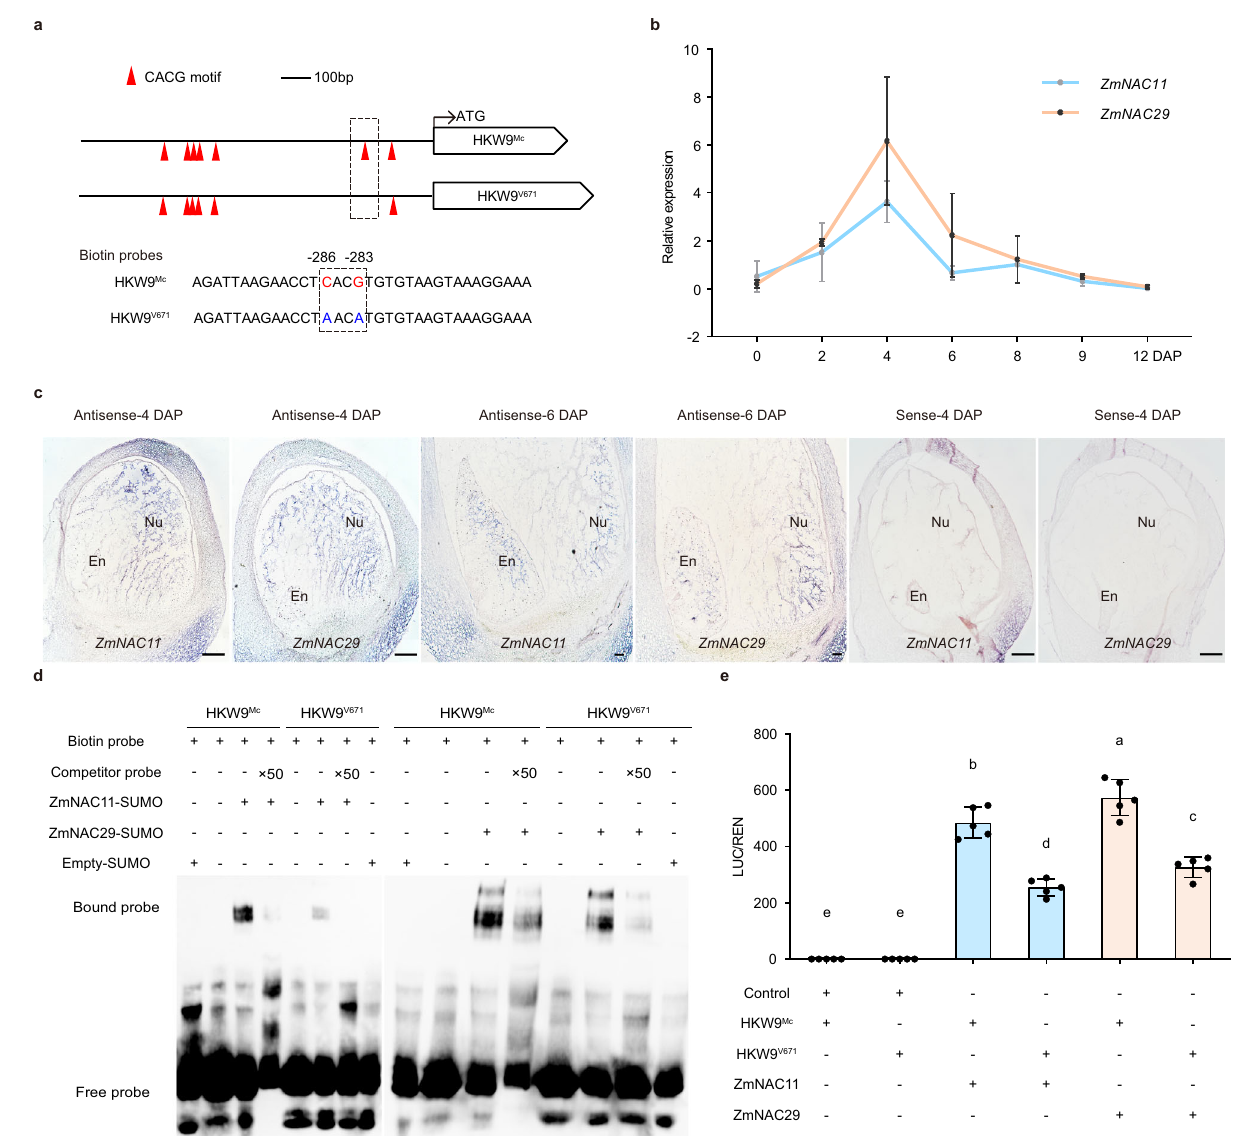
Fig. 5 | Nucellus-expressed ZmNAC11 and ZmNAC29 bind to and activate ZmEXPB15 . a Schematic diagrams of the promoters of HKW9 Mc and HKW9 V671 . The red triangles represent in vitro CACG motifs. The dashed box represents the positions of the biotin probes ( b ), qRT-PCR analysis of ZmNAC11 and ZmNAC29 expression during early kernel development of 0 to 12 DAP. All expression levels from three biological repeats were normalized to Actin . c In situ localization of ZmNAC11 and ZmNAC29 expression in the developing kenrels at 4 and 6 DAP. Positive signals were found in the nucellus (Nu) and endosperm (En) using the ZmNAC11 and ZmNAC29 antisenseprobes.The controlwasperformed using4-DAP kernel with ZmNAC11 and ZmNAC29 sense probes. Scale bars=50 μ m. d DNA binding af fi nities of the recombinant ZmNAC11 and ZmNAC29 proteins on the